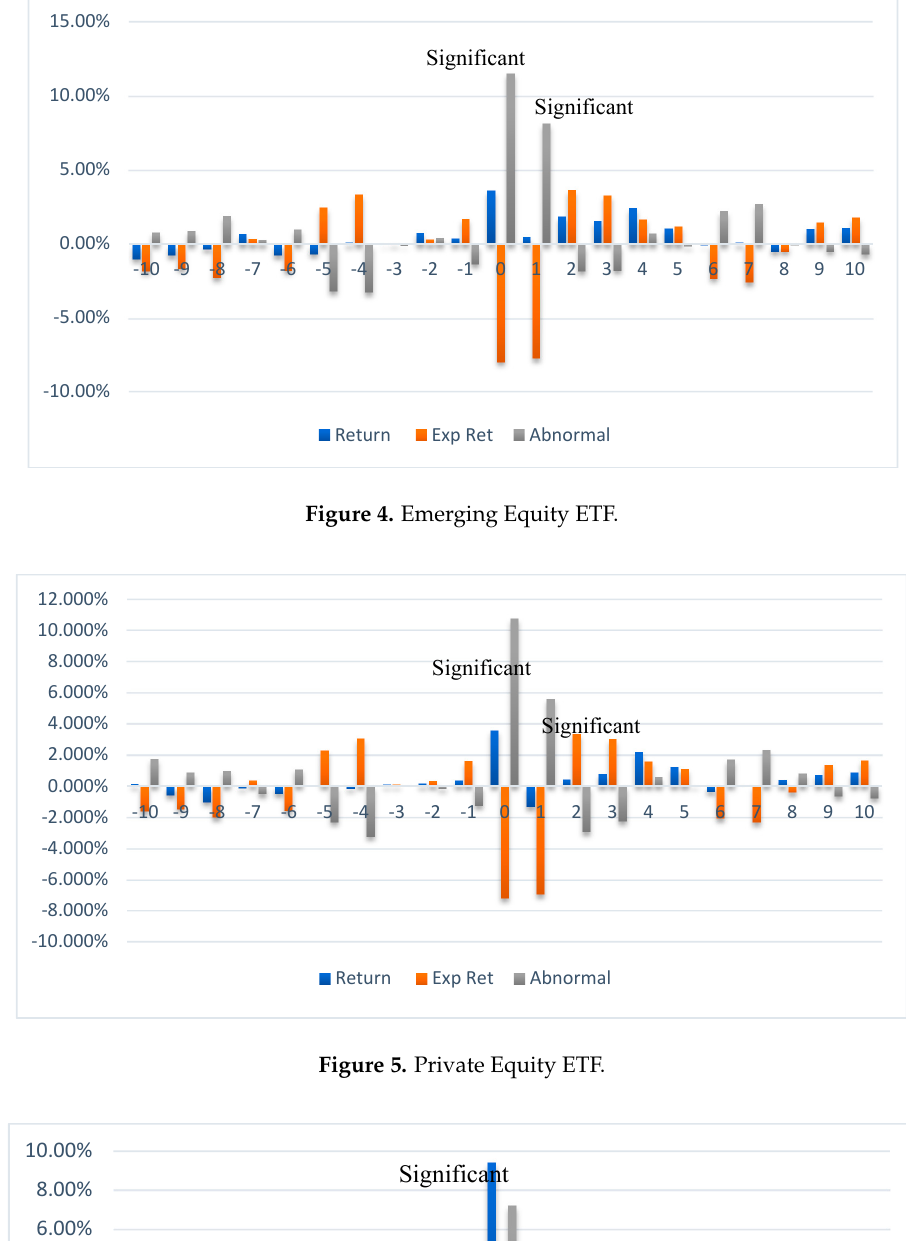
Figure 3. European Equity ETF.